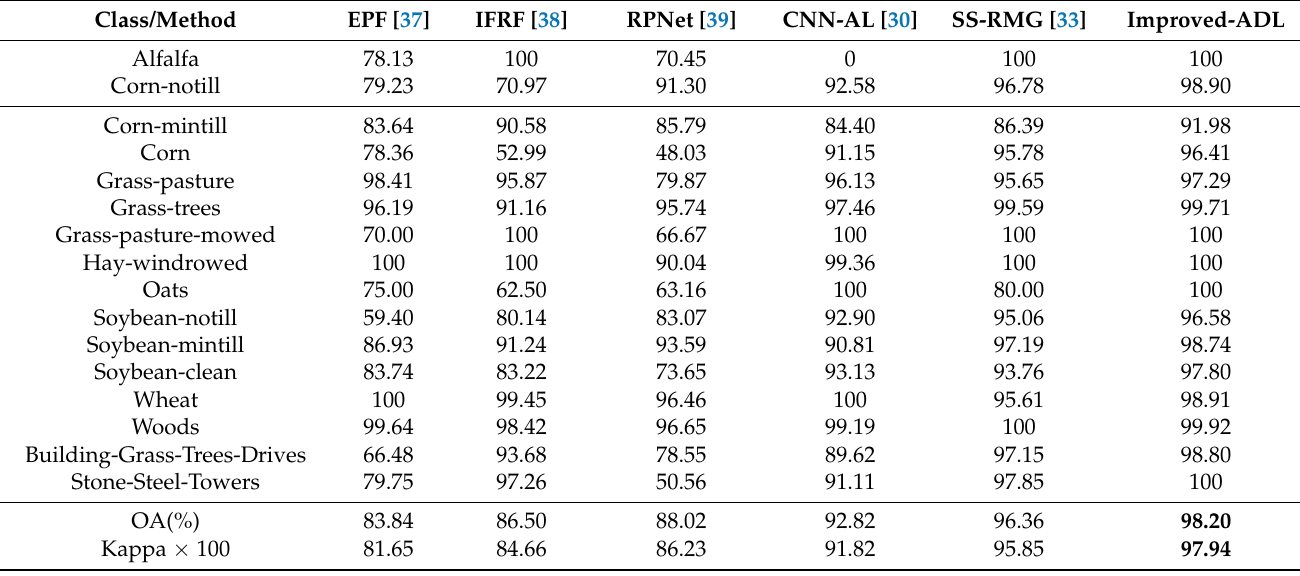
Table 6. Classification results of different methods on the Indian Pines dataset.